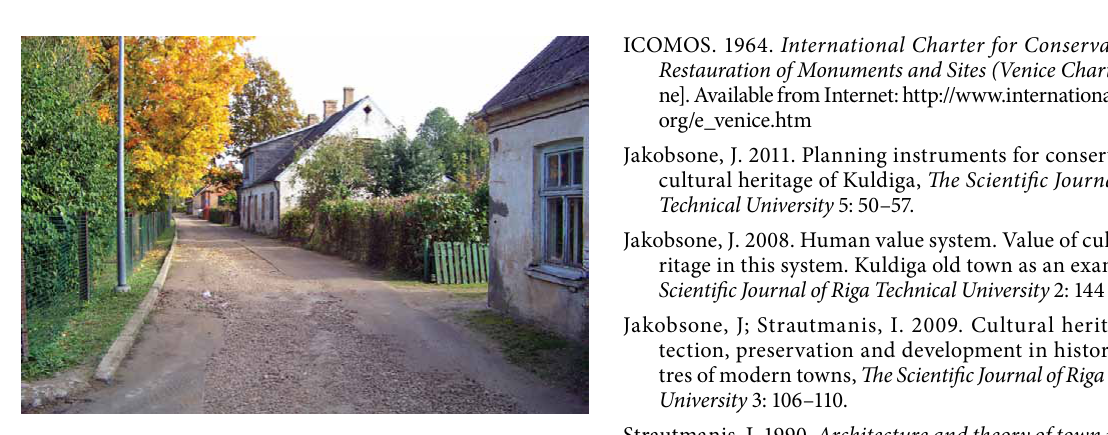
Fig. 10. The spaced historical building and green structure in Kaleju street. Source: author’s photo,